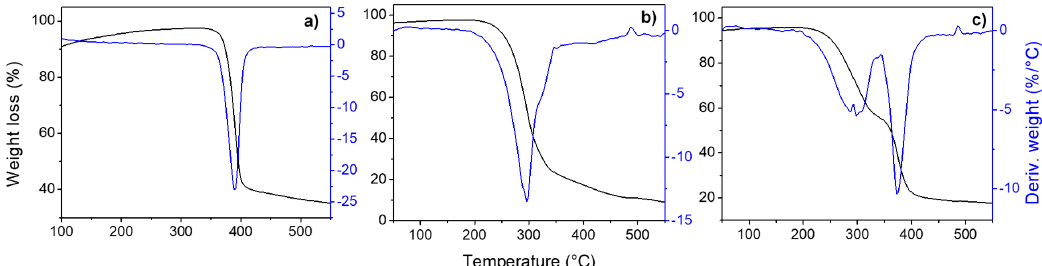
Figure 2. Thermogravimetric (TG) and derivative thermogravimetry (DTG) curves for ( a ) clotrimazole, ( b ) itraconazole and ( c ) the binary mixture of clotrimazole and itraconazole (1:1).